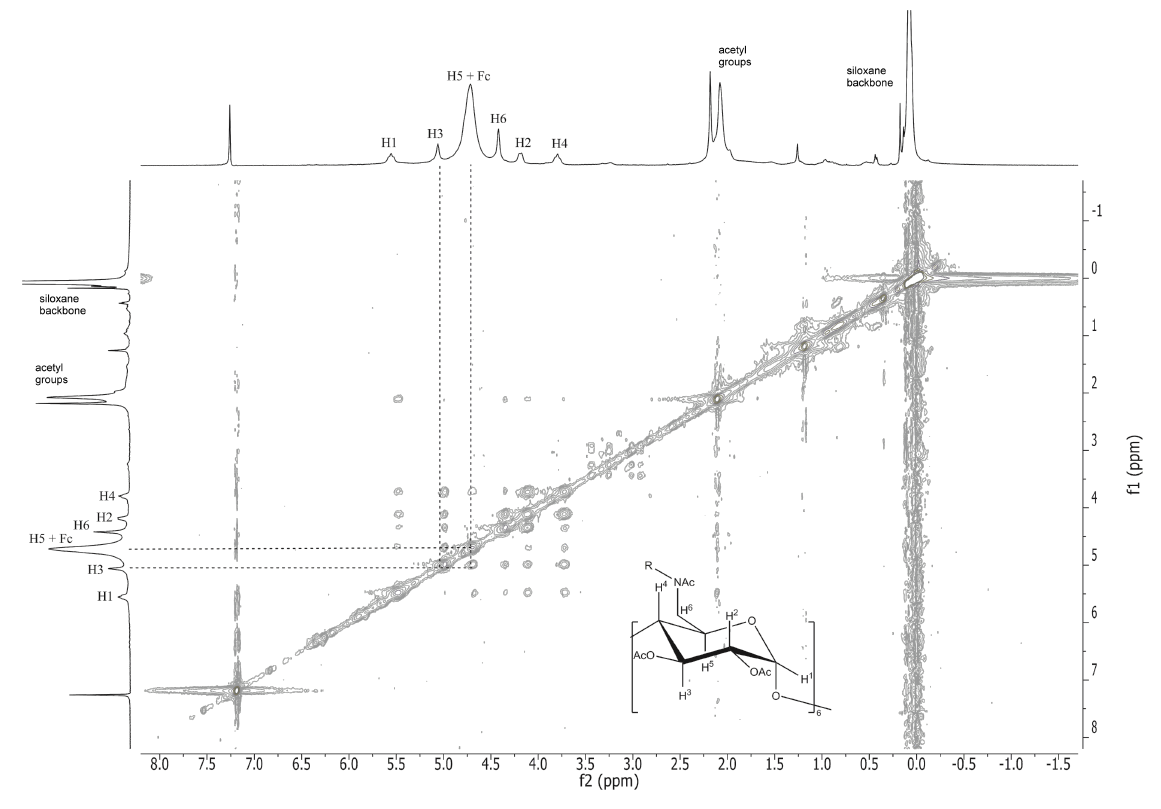
(Figure 5B), elongated structures of up to 4000 nm can be observed. This phenomenon might be explained by the supra- molecular linkage of the short-chain disiloxanes by interaction with the bifunctional ferrocene molecules, which leads to the formation of the larger structures.